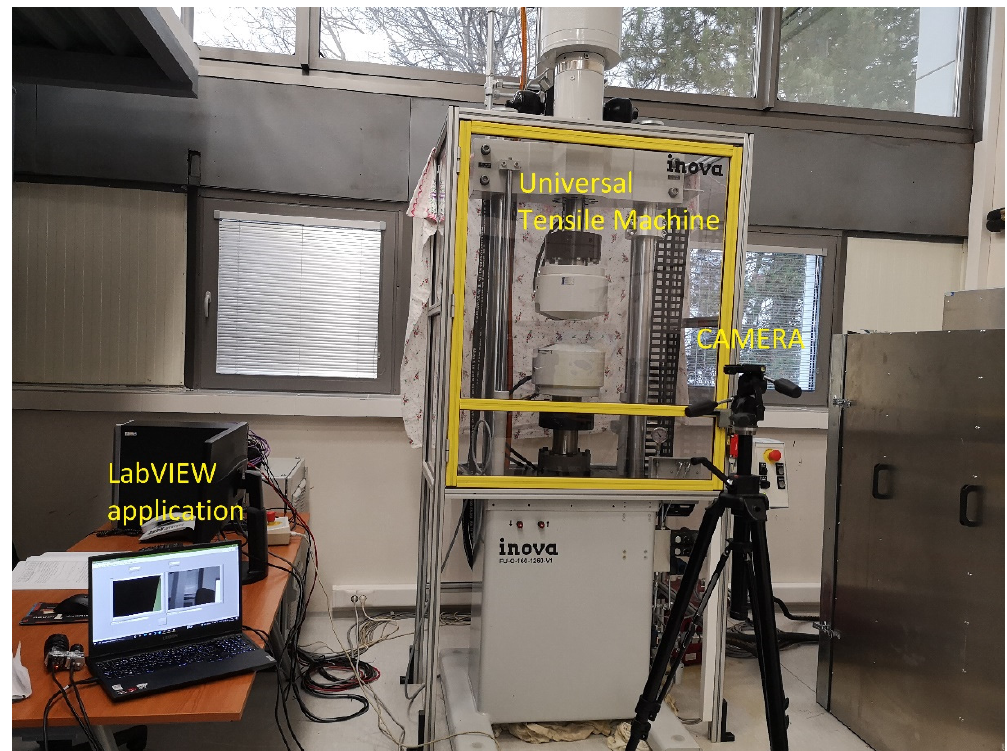
Figure 3. Video extensometry.